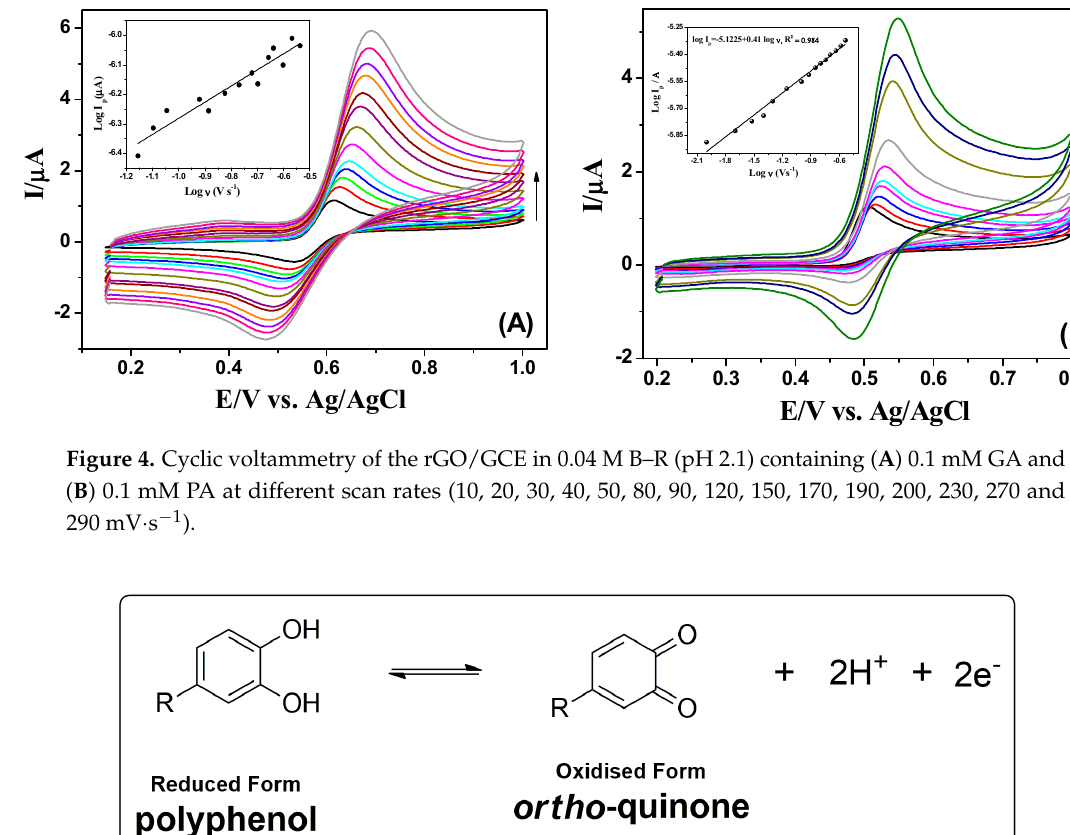
Scheme 1. The oxidation mechanism of polyphenol.